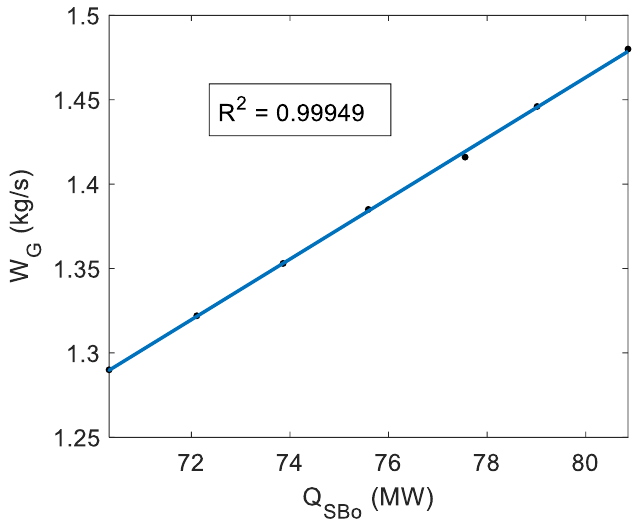
Figure 8. Linearity between Q SBo and W G